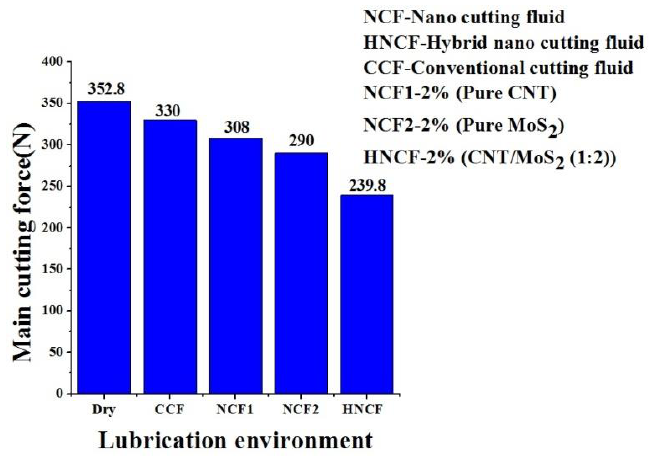
Figure 3. Variation of main cutting force with different lubrication environment (CS=80m/min, FR=0.161mm/rev and DOC =0.5 mm)